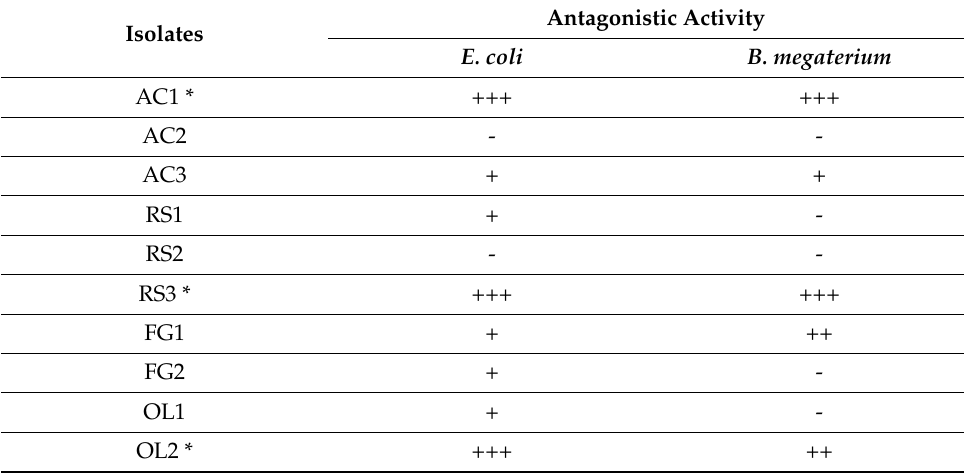
Table 1. Antagonistic activity of the Actinomycetes isolates.